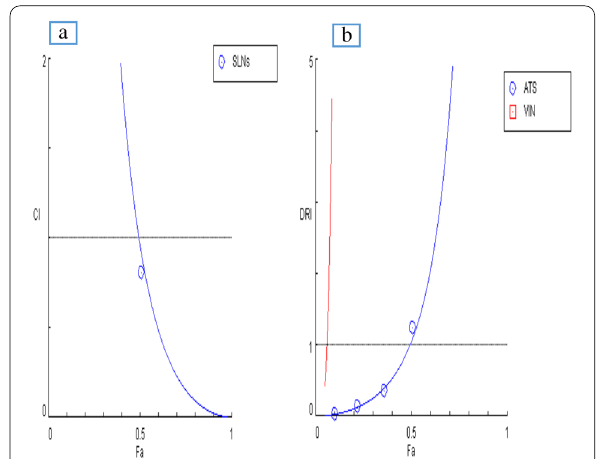
Fig. 9 Synergistic effect of SLNs a Fa-CI values of SLNs, b DRI plot of SLNs